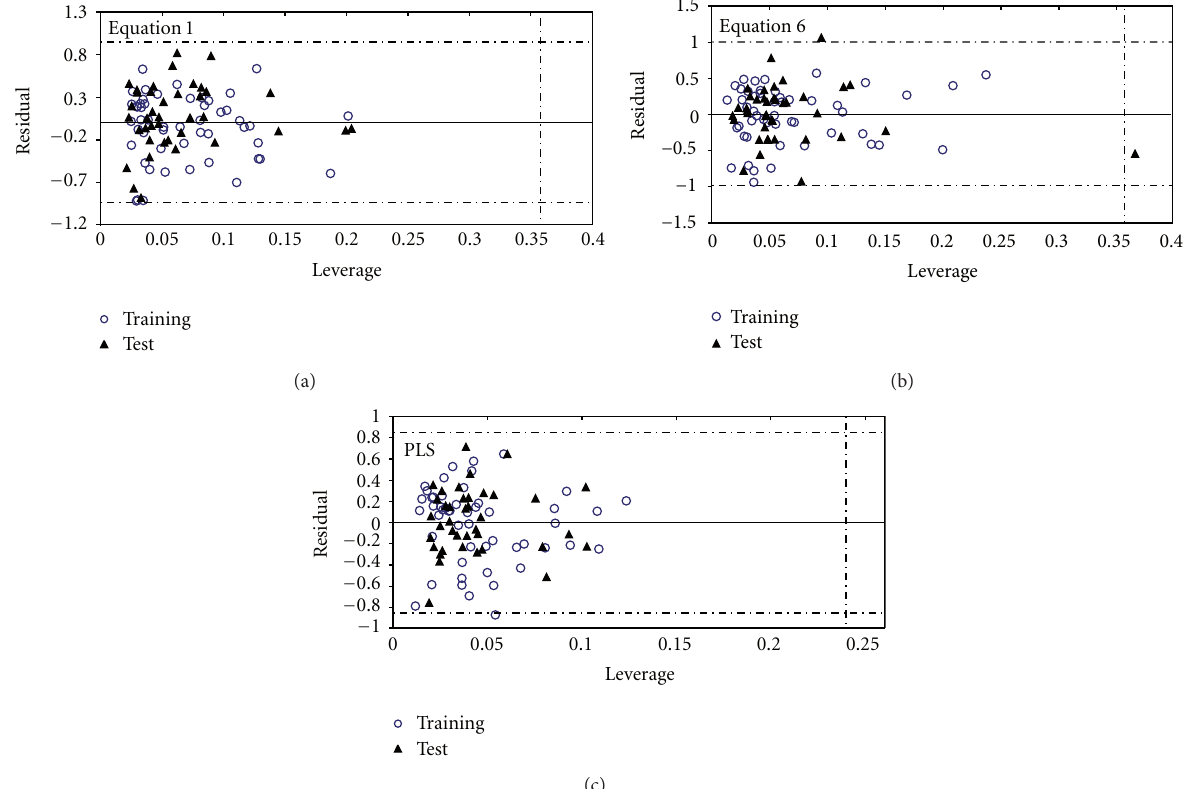
(c) F 3: Williams plot (applicability domain) of the training compounds and external prediction set compounds for Eq. (1) and Eq. (6) and 3-component PLS equation of 18 descriptors. Cut-off value of leverage for Eq. (1) and Eq. (6) is 0.366 and for PLS model is 0.24; for residual cut-off value is taken as 2.5 of standard